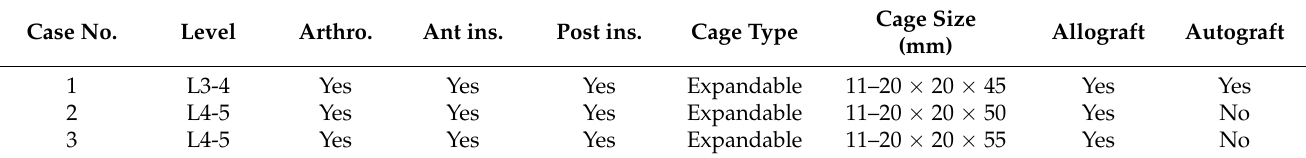
Table 3. ACR cases surgical data.